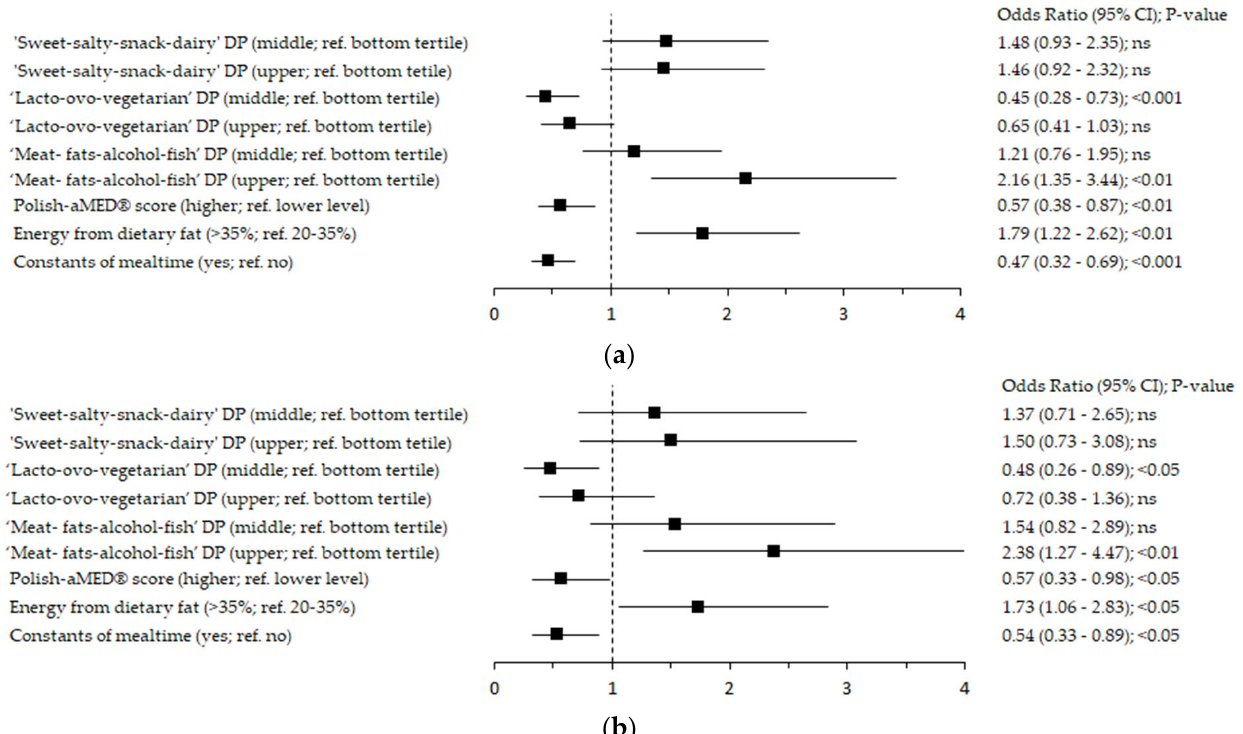
Figure 1. Forest plots of the adherence to the dietary patterns, percentage energy from dietary fat, and constants of mealtime among healthcare workers working in shift mode (ref. daily mode) (n = 445): ( a ) crude model; ( b ) model adjusted for: age (years), gender (men, women), socioeconomic status index (SESI, points), BMI (kg/m 2 ), physical activity (GLTEQ summary, points), current smoking status (non ‐ smoker, smoker), alcohol drinking within the last 12 months (no, yes), chronic diseases (no, yes), taking medication >1 year (no, yes), and vitamin/mineral supplements use within the last 12 months (no, yes). DP — dietary pattern; Polish ‐ aMED ® — Polish ‐ adapted Mediterranean Diet (range of points: 0–8); ref. — referent, the reference categories were the bottom tertile/lower level of dietary patterns and the lower level of the percentage of energy from dietary fat; 95% CI—95% confidence interval; p ‐ value—the level of significance was assessed by Wald’s test.